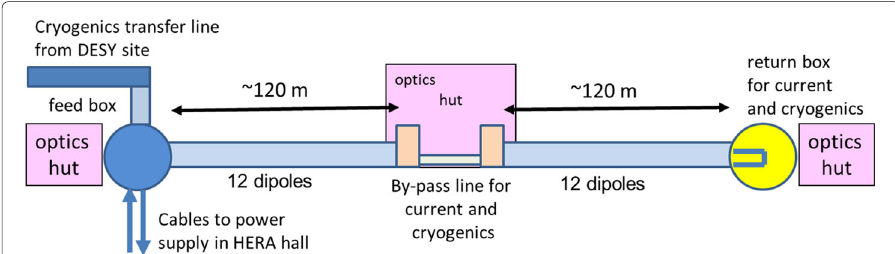
Fig. 3 Schematics of the experimental setup of ALPS II in a straight section of the HERA tunnel. The two strings of 12 straightened dipoles each are connected by a vacuum insulated bypass line for cold Helium and the magnet current, leaving sufficient space for the setup of the optics in the middle of the experiment. The Helium and the current for the magnet strings are supplied at the box closest to the DESY